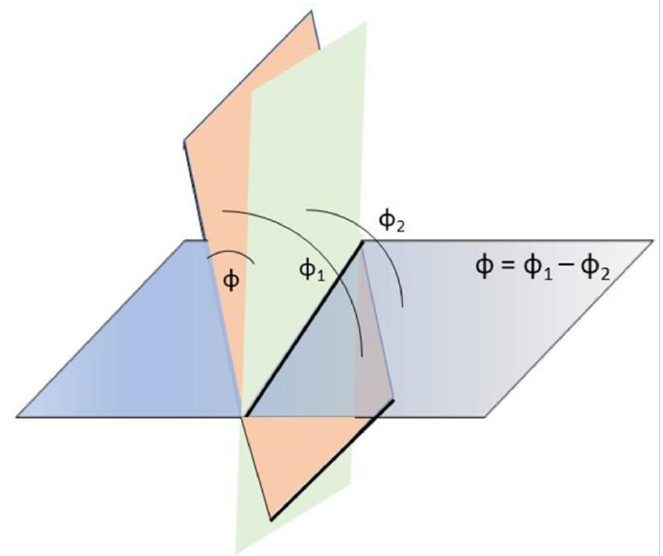
Figure 7. Representation of the angular difference between the plane describing reality and the plane determined by the algorithm